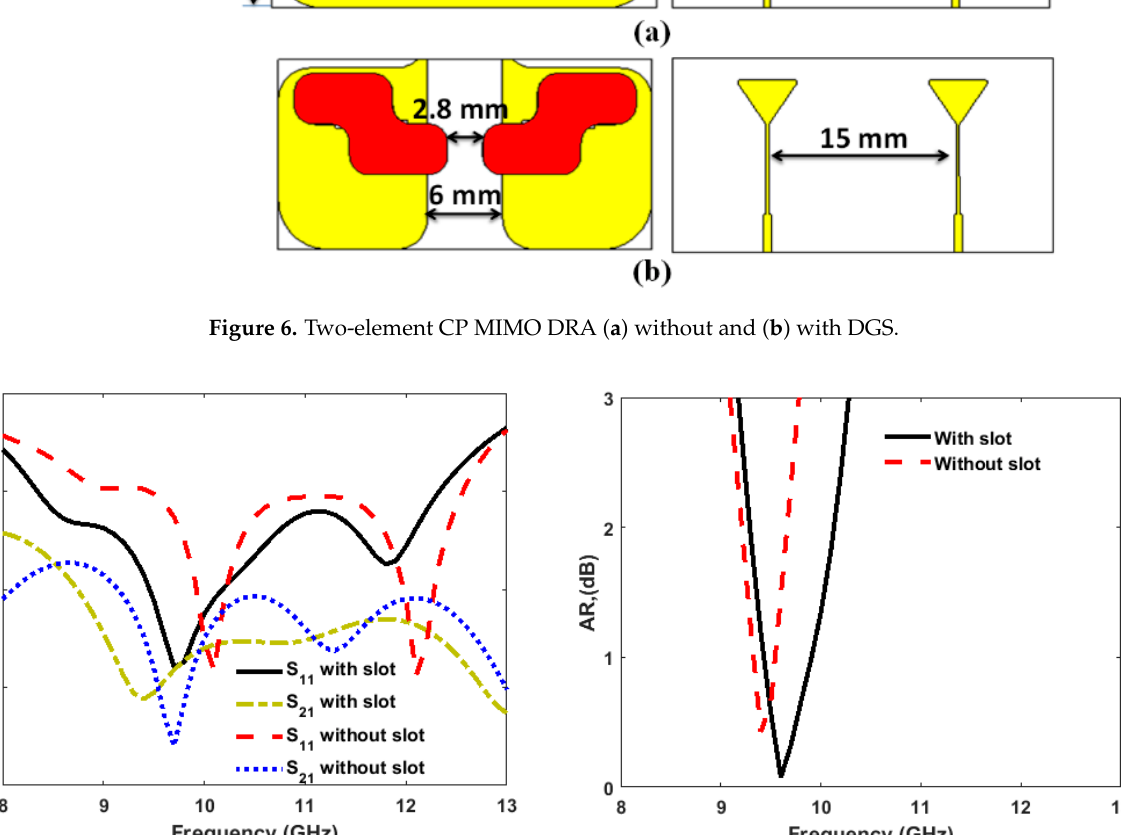
Figure 7. ( a ) S-parameters and ( b ) AR response of two-port antenna with and without slots in the ground plane. Table 1. Performance of a two-port